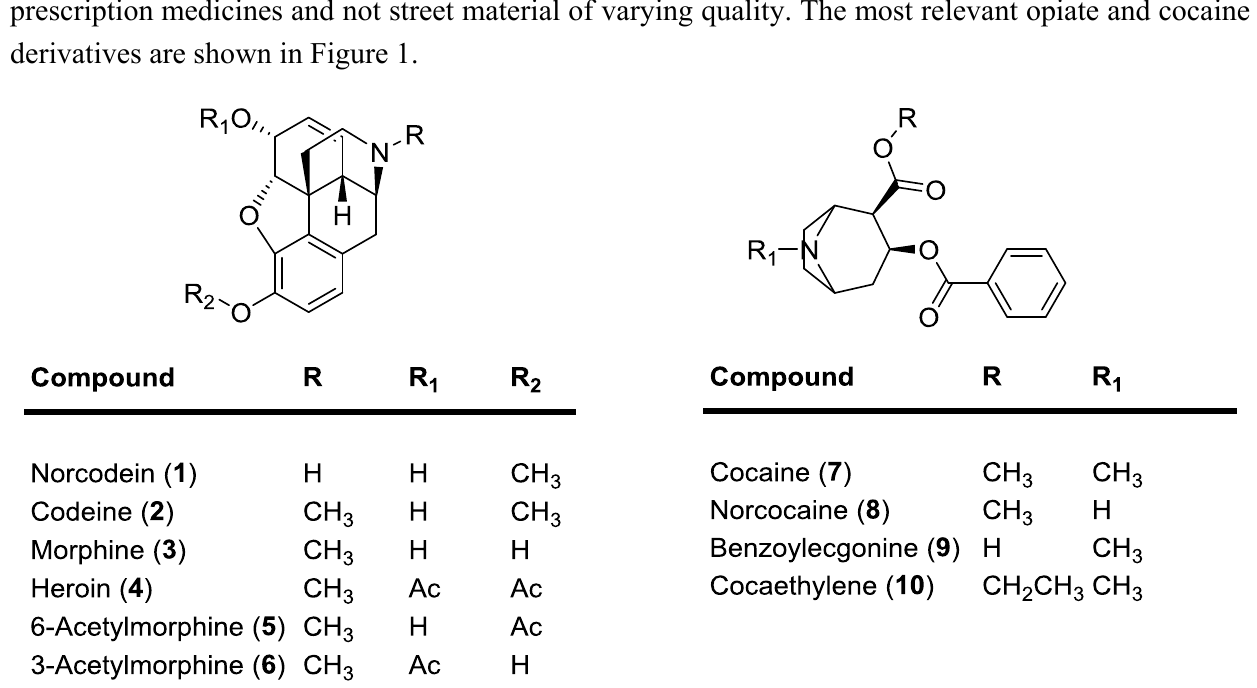
Figure 1. Opiate and cocaine derivatives focused on in this